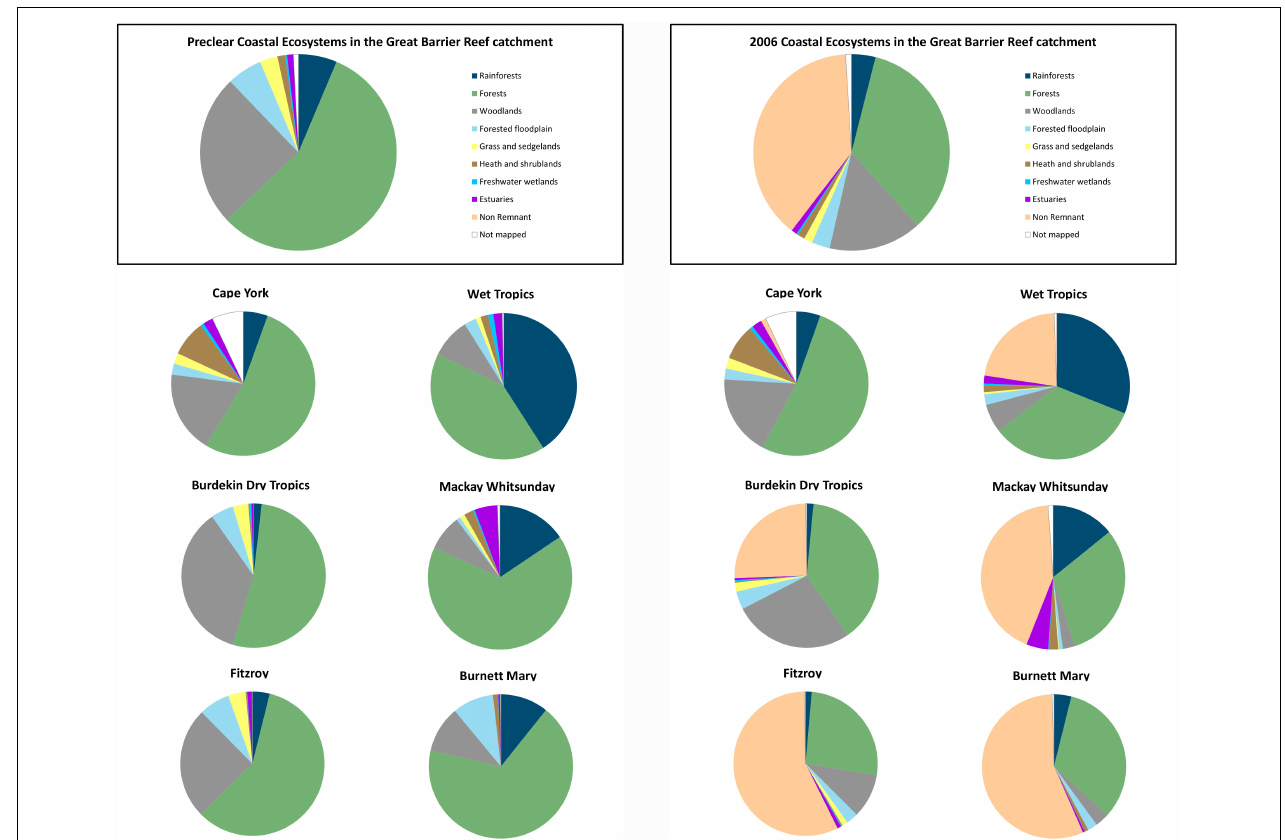
FIGURE 3 | Mapped land use change between preclear and 2009 coastal ecosystems in the GBR. Natural Resource Management areas mapped in Figure 1